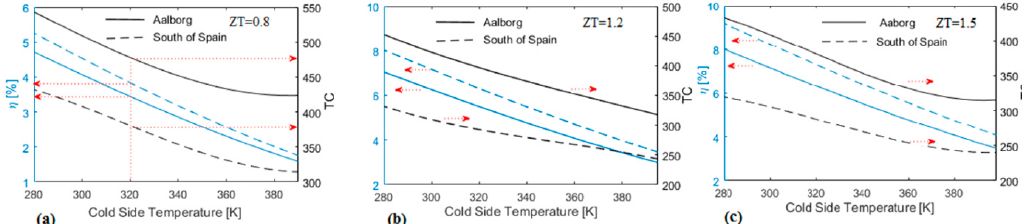
Figure 11. Maximum efficiency and corresponded TC for different values of ZT ( a – c ) in the case where cold side temperature is constant.